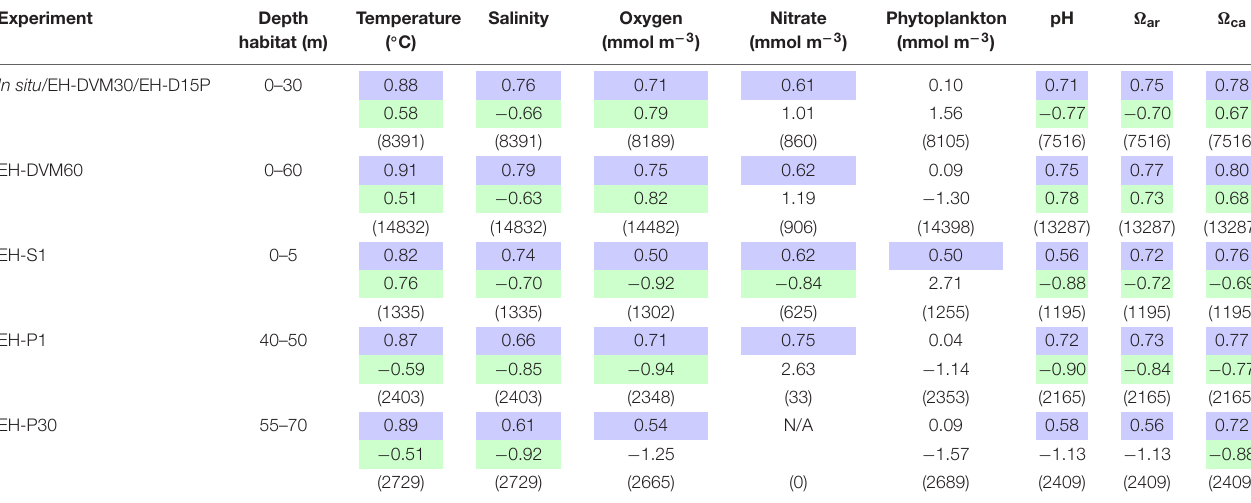
TABLE 3 | Skill assessment of J-SCOPE historical ocean simulation variables that will be considered as potential predictor variables during megalopae occurrence GLM development.